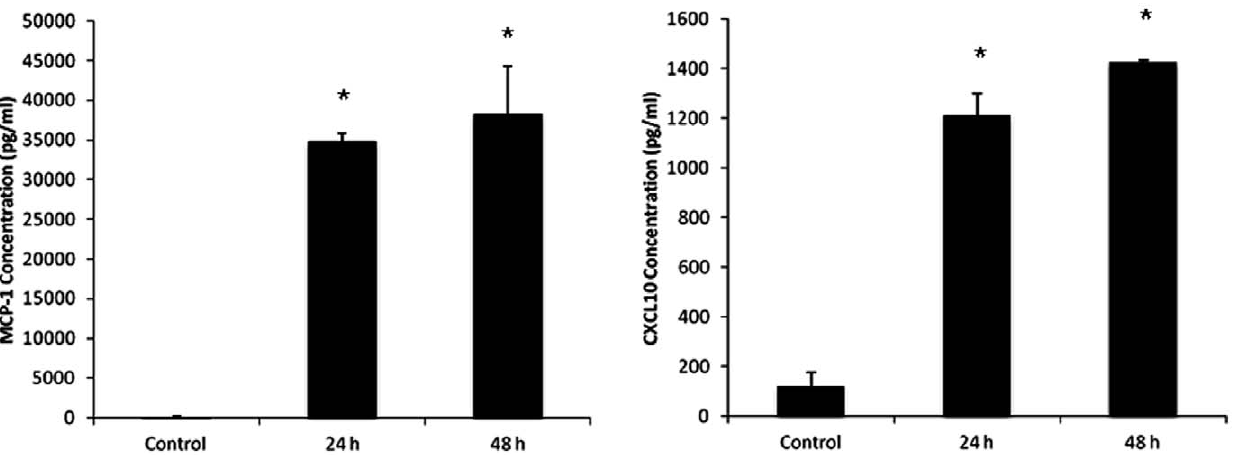
Figure 3. Cytokine concentrations in glioma-conditioned media (GC-Media) and standard culture media (Media). Cytokine concentrations were measured using Human ELISA Kits. (A) Increased MCP-1 concentrations in GC-Media (* p , 0.0001, 24 h or 48 h vs. control). (B) Increased CXCL10 concentrations in GC-Media (* p , 0.0001, 24 h or 48 h vs. control). The data represents the means 6 SD of three independent experiments.